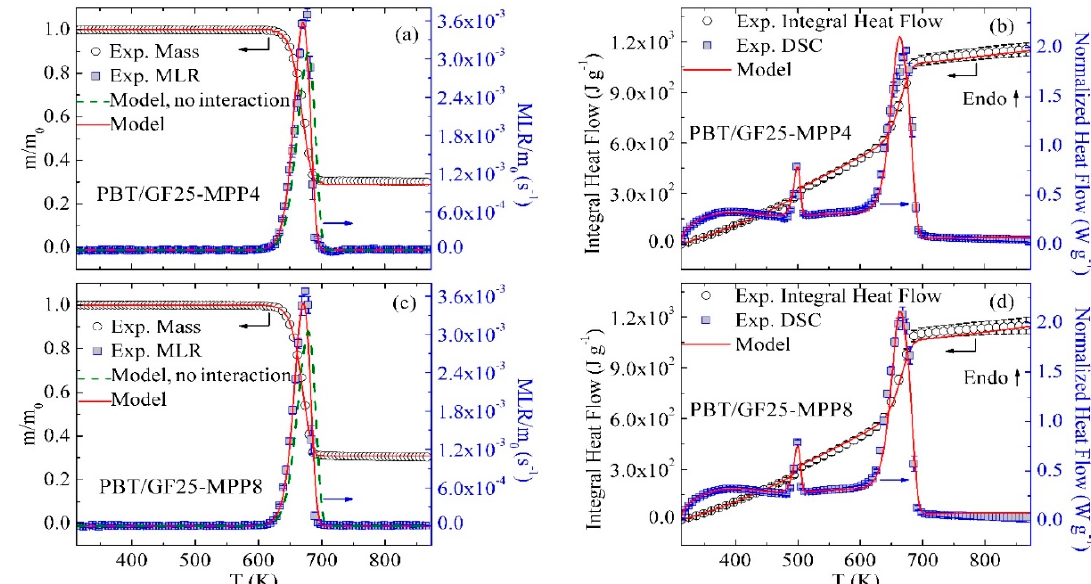
Figure 4. Experimental and simulated TGA and DSC data obtained for ( a , b ) PBT/GF25-MPP4 and ( c , d ) PBT/GF25-MPP8 at 10 K · min − 1 .